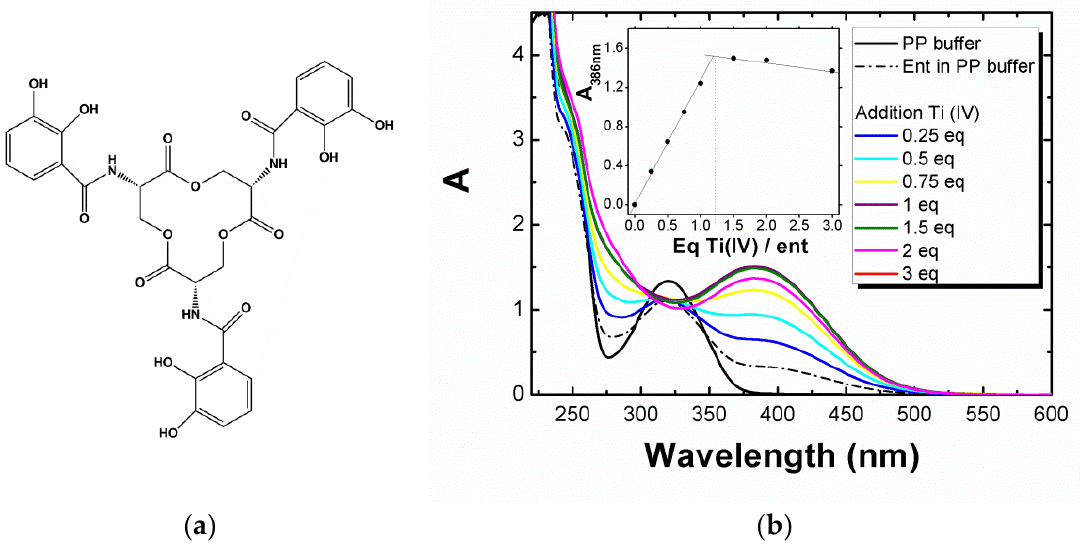
Figure 1. ( a ) Molecular structure of the enterobactin siderophore ( ent ) and ( b ) enterobactin metalla- tion (100 µM) followed by UV – visible spectroscopy by successive additions of Ti(IV) equivalent (TiCl 4 , 1 mM) in the PP medium. (Inserts) Determination of the stoichiometry of the Ti – enterobactin complex by following the evolution of the absorbance at 386 nm during addition of Ti(IV). A = ab- sorbance.